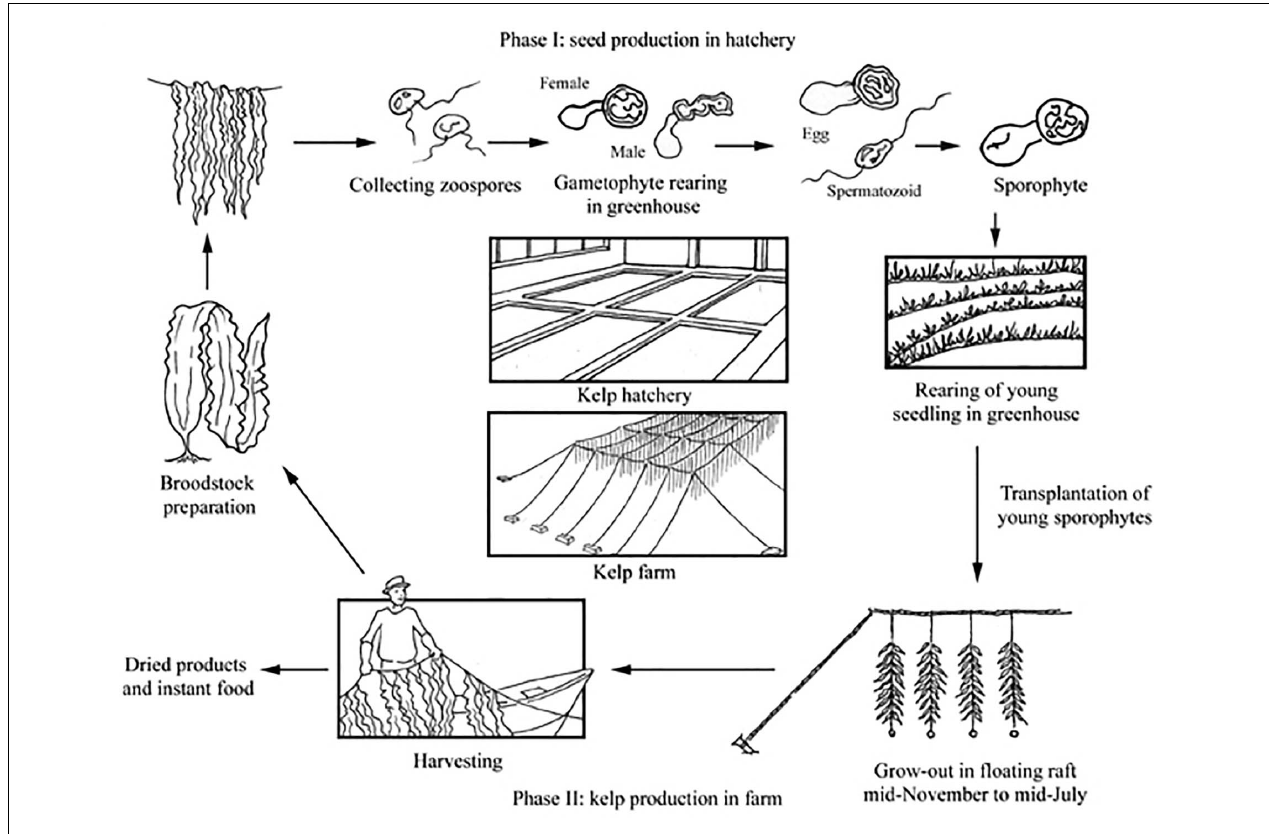
FIGURE 1 | Production cycle of Japanese Kelp ( Saccharina japonica ) in China, from FAO